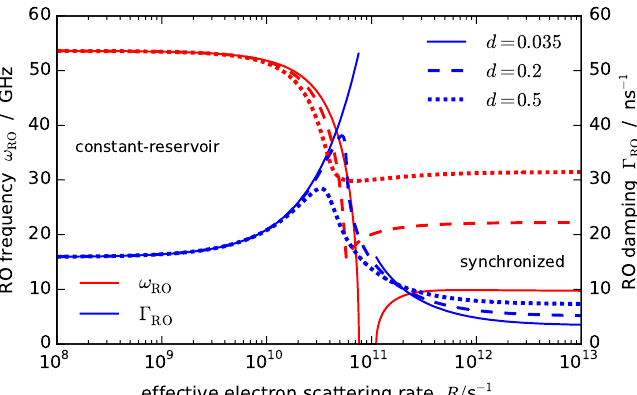
Figure 2. RO frequency ω (red) and damping rate Γ (blue) determined from RO RO Equation (7) for different QD-quantum-well (QW) carrier distribution coefficients: d = 0 . 035 (solid line) describing small energy separation, d = 0 . 2 (dashed line), and d = 0 . 5 (dotted line) corresponding to a large energetic distance. Other parameters as in Figure